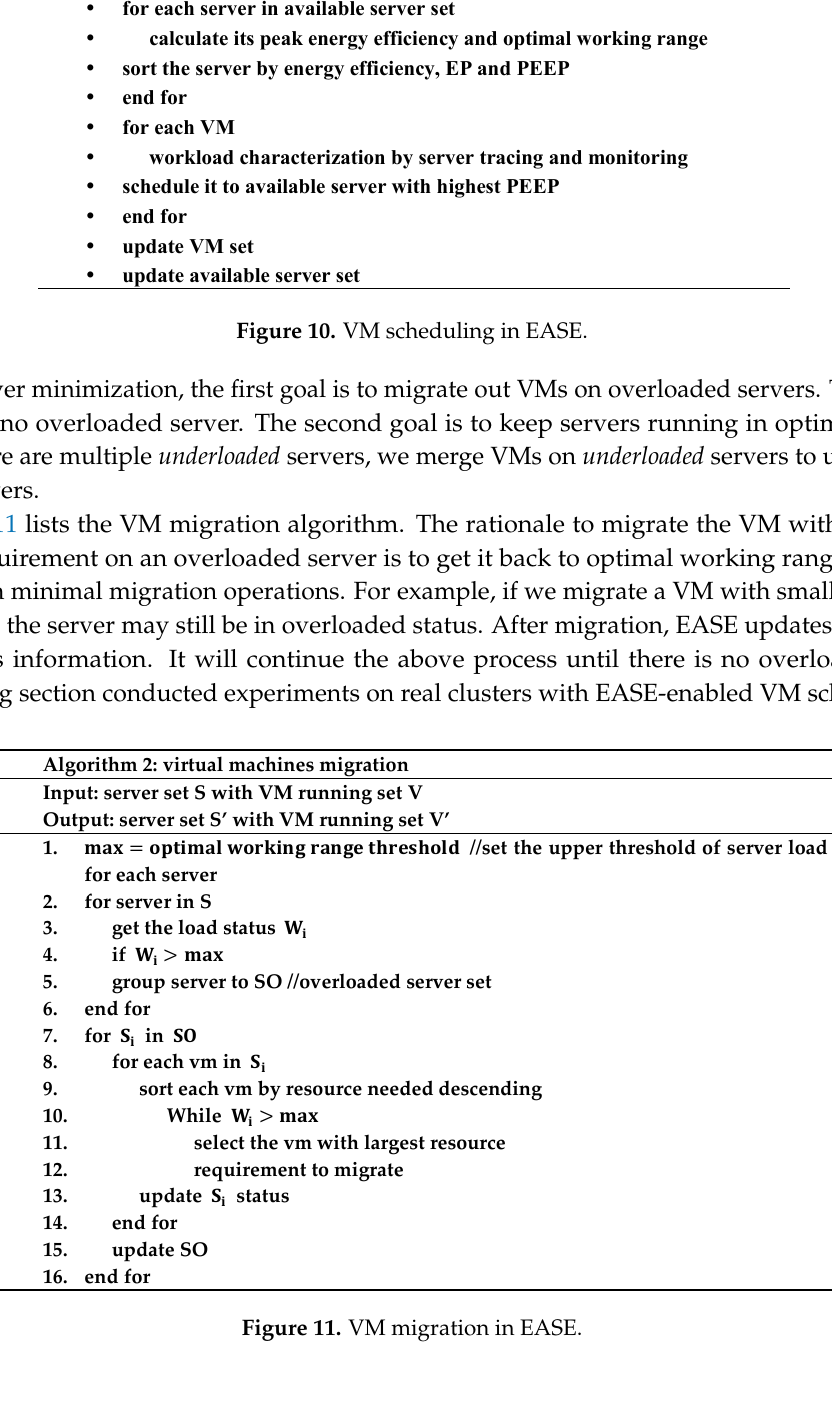
Figure 11. VM migration in EASE.